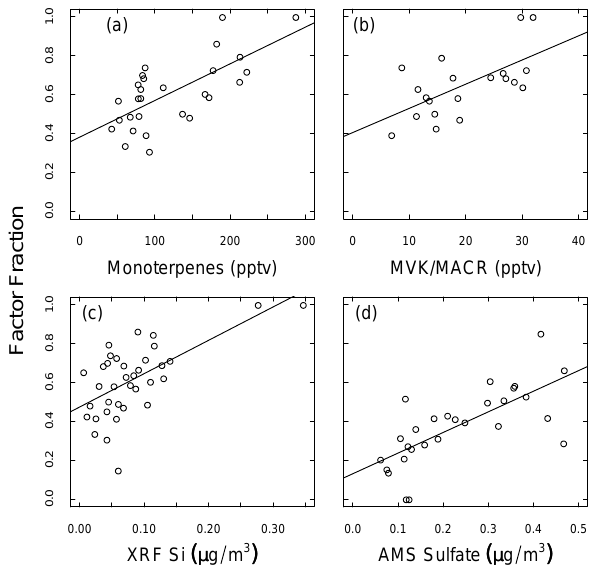
Fig. 5. Comparison of PMF fractions and important tracers. Bio- genic factor fraction and (a) monoterpenes, (b) MVK/MACR (c) Si, and Combustion factor fraction and (d) sulfate. Comparison in- cludes 12 h samples with OM above detection, with four samples during 17–18 May omitted because the flow control was not oper- ating during this time and PTR-MS measurements when the VOC were measured adl for more than 80% of the filter time. (OM con- centrations were considered bdl for samples in which OFG mass contributions that were bdl accounted for more than 20% of